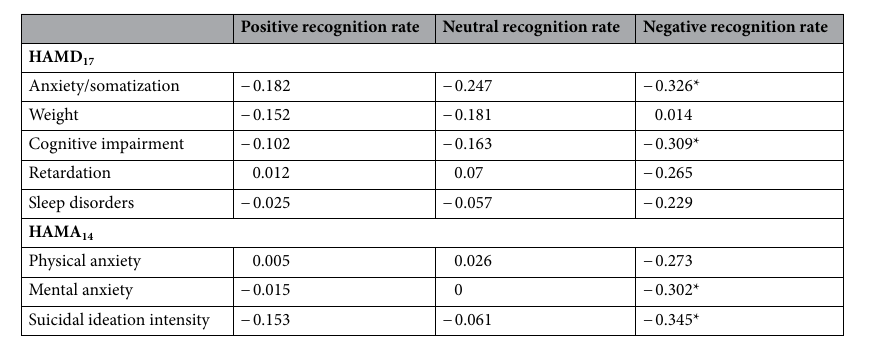
Table 3. Without suicidal ideation group and with suicidal ideation group correlation between accuracy of emotional memory test and scale scores (n = 86). *p <